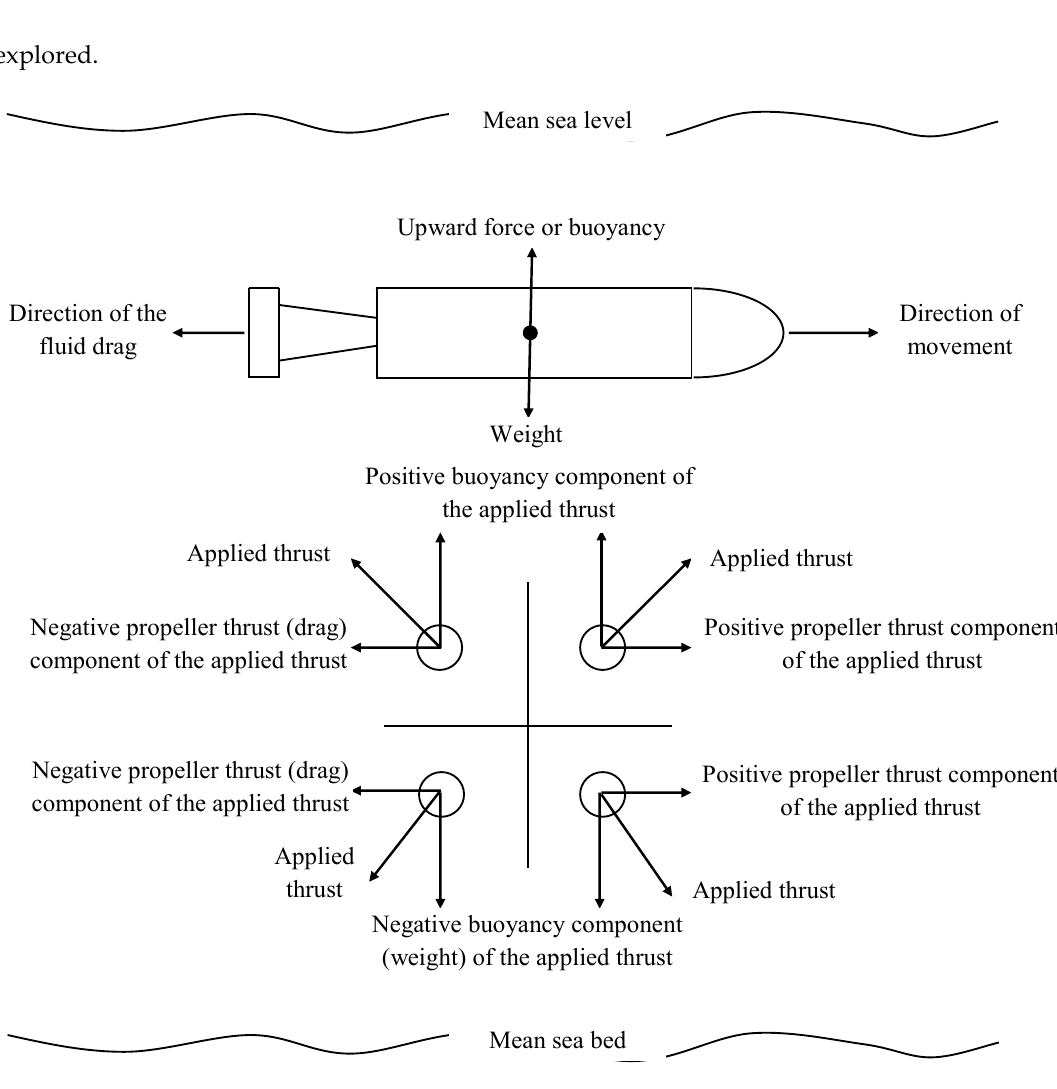
Table 1. List of the Underwater Vehicles (UVs) that use the Variable Buoyancy System (VBS) and their limitations.